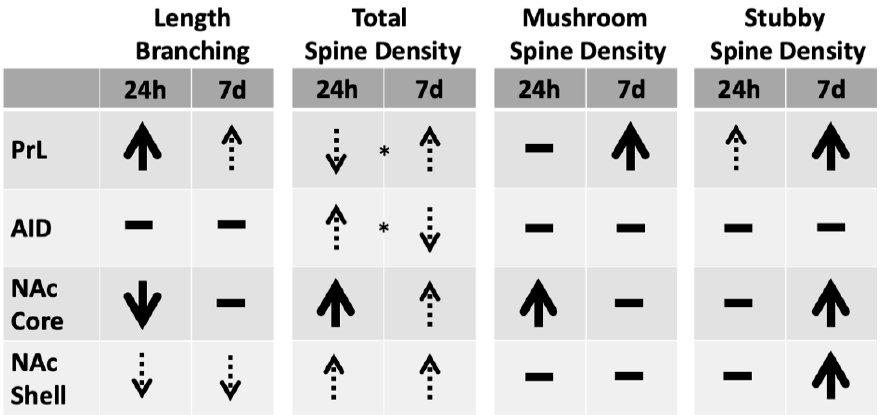
Figure 7. Summary of major findings from the present study and those reported in [1] for the 24 h and 7 d groups (relative to control). Significant modifications in dendritic length and spine density are indicated by large solid arrows. Non-significant trends are indicated in dotted lines. In some cases (e.g., total spine density for PrL) dotted arrows marked by * are included to reflect numerical trends from the control condition and significant differences between the 24 h and 7 d groups. Horizontal bars indicate no change from control.